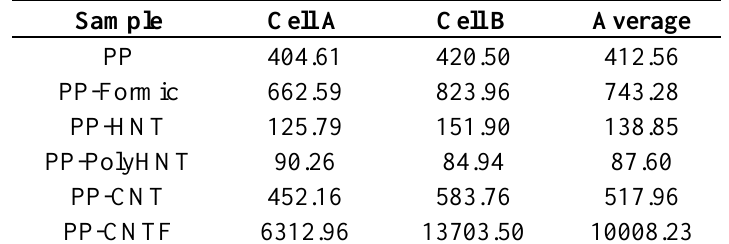
Table 6. Oxygen transmission rate of samples in (cc/m 2 -day).